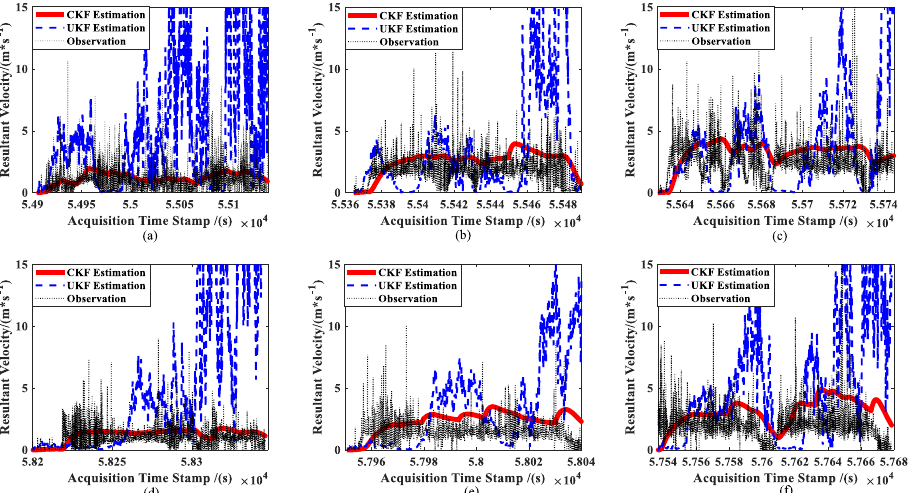
Figure 11. Comparison of ship resultant velocity estimations: ( a ) slow speed of MRM, ( b ) medium speed of MRM, ( c ) high speed of MRM, ( d ) slow speed of ANM, ( e ) medium speed of ANM, and ( f ) high speed of ANM.